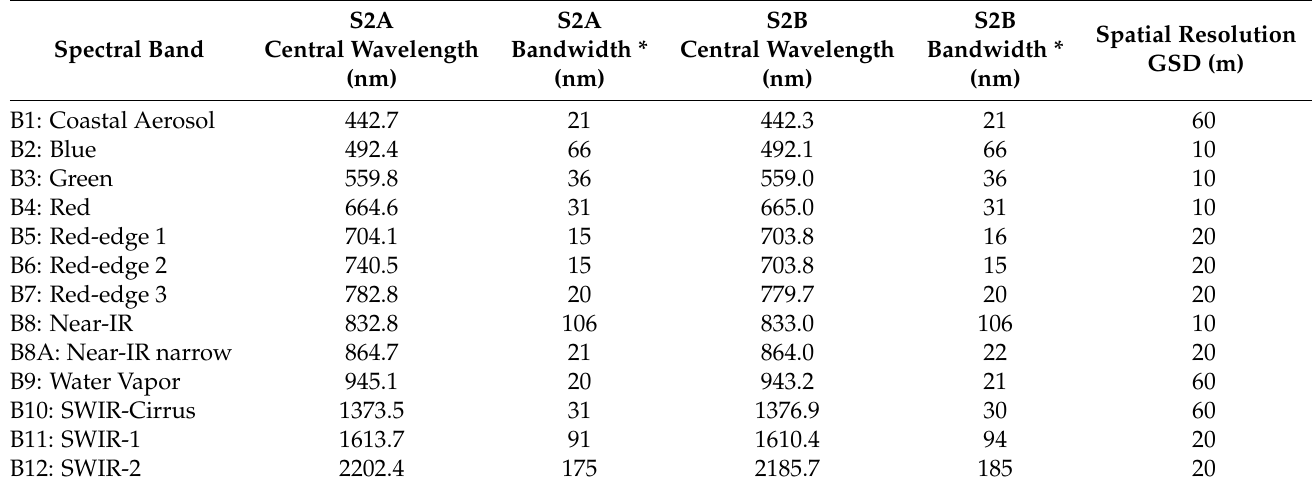
Table 1. Spatial and spectral characteristics of Sentinel-2 bands. Source: [37].